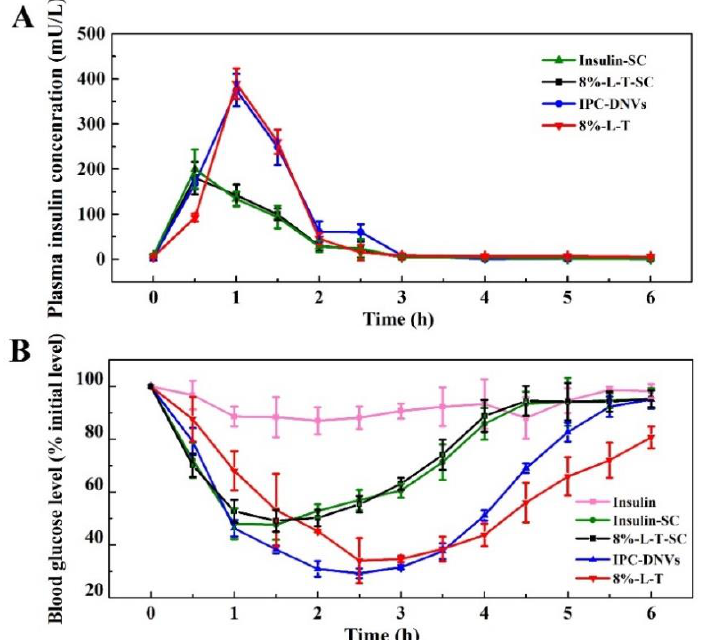
Figure 9. Time-dependent ( A ) plasma insulin concentrations ( B ) and in vivo hypoglycaemic effect. Table 7. The relative bioavailability ( Fr ) and relative pharmacological bioavailability ( Fp ) of 8%-L-T.